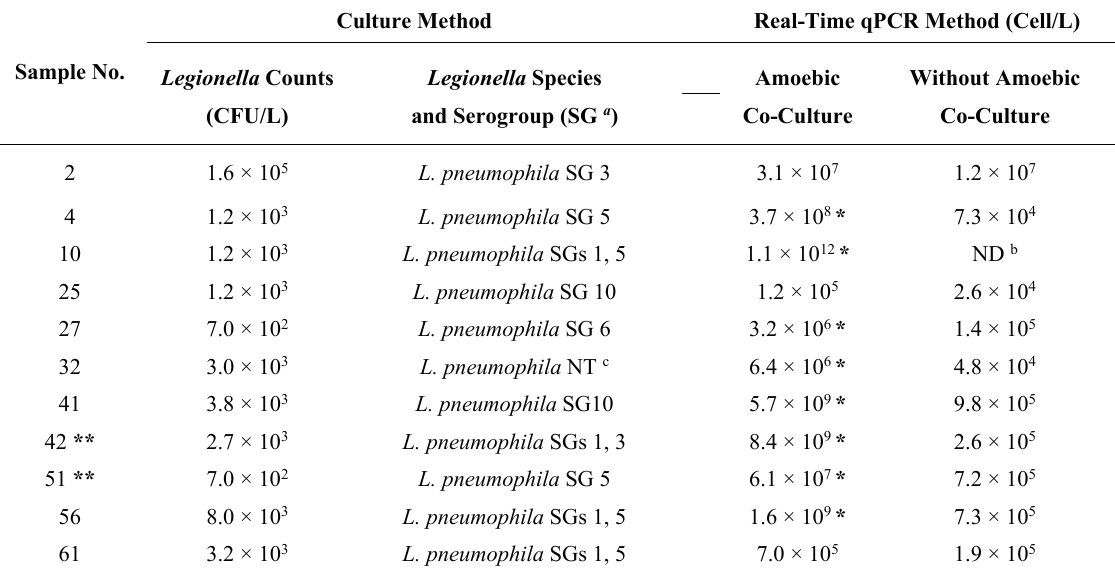
Table 1. Results of the real-time qPCR in the culture-positive 11 bath water samples.